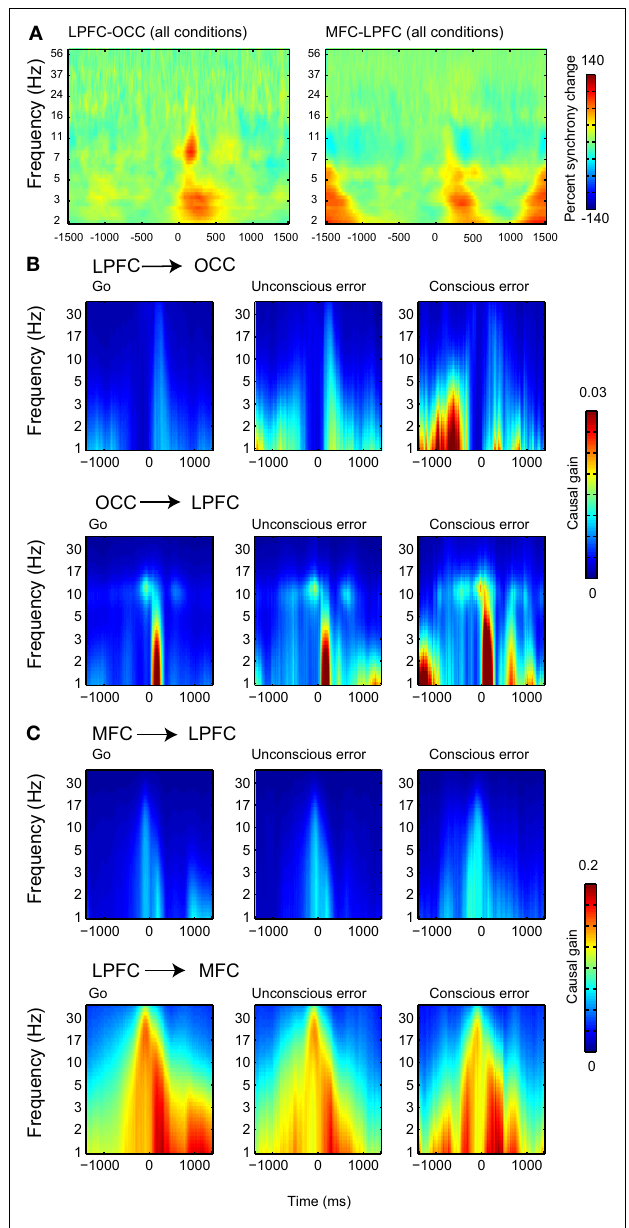
FIGURE 7 | Synchrony with lateral PFC (LPFC). (A) LPFC oscillatory phase synchrony with OCC (left) and MFC (right) averaged over conditions. (B) Spectral Granger causality estimates between LPFC and OCC. Differences among conditions were only marginally signifi cant, and MFC → OCC directed synchrony was signifi cantly stronger than was LPFC → OCC directed synchrony. (C) Spectral Granger causality demonstrates strong activation fl ow from LPFC → MFC, which was not signifi cantly different according to condition. In contrast, MFC → LPFC directed synchrony was relatively weaker, but was signifi cantly different across conditions, in a manner similar to that observed for MFC →